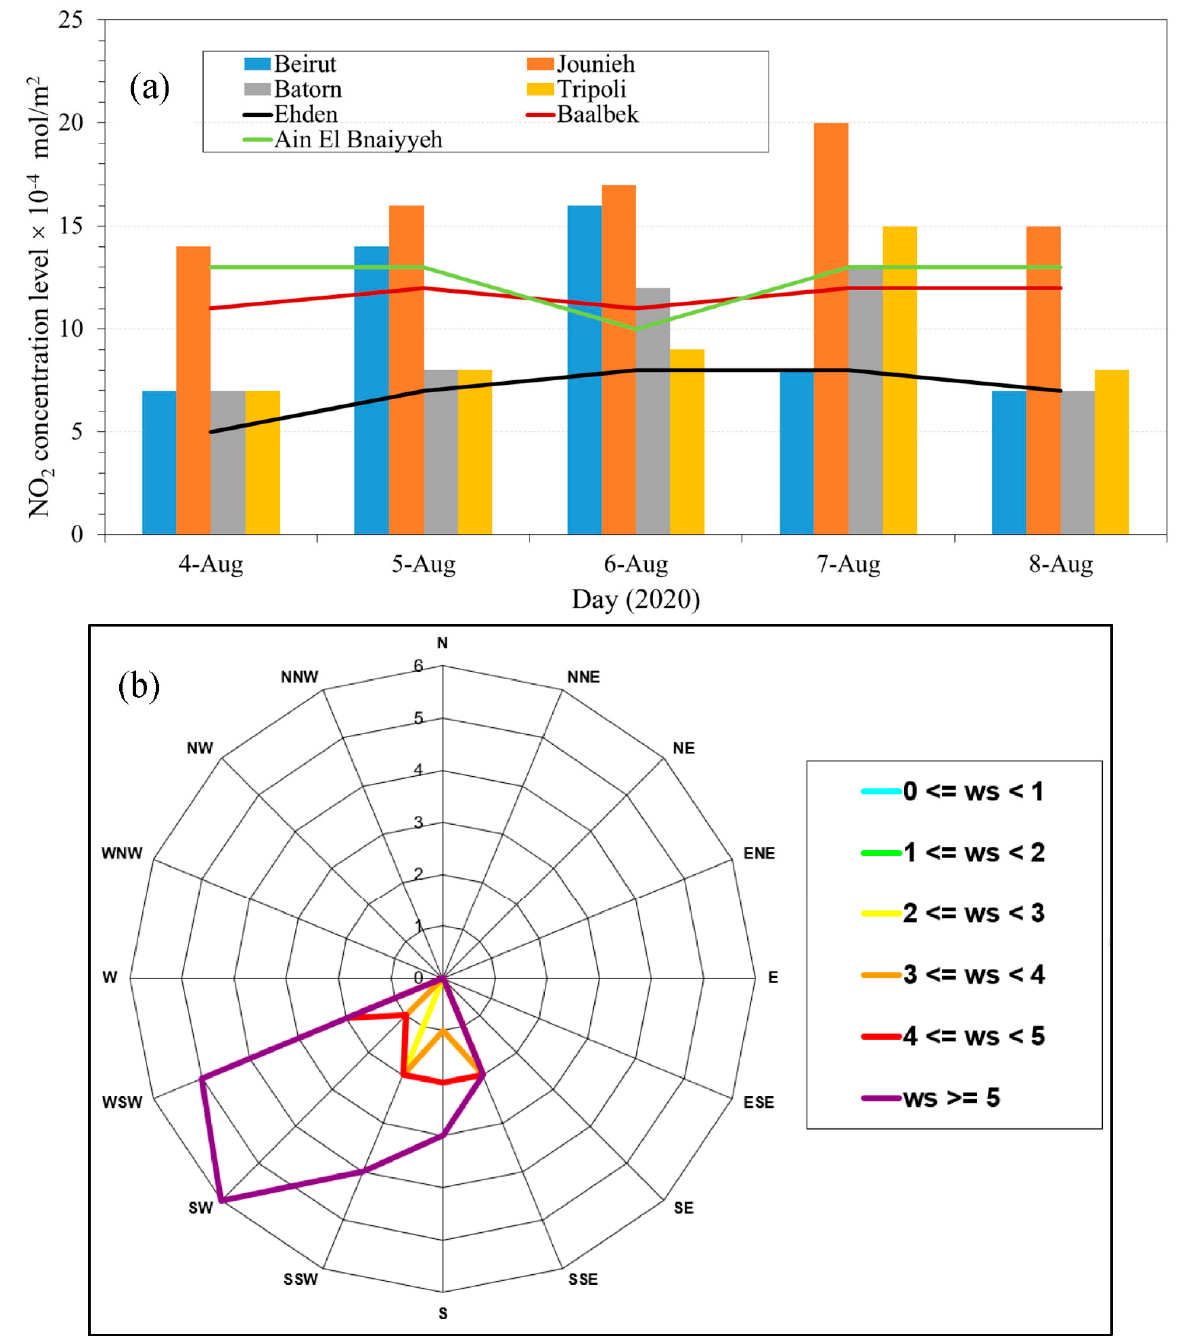
Figure 9. ( a ) NO 2 concentration levels × 10 − 4 mol/m 2 from 3 to8 August 2020 in the eight locations. Coastal locations (Beirut, Jounieh, Batron, and Tripoli) are represented by bars and inland locations (Ehden, Baalbek, and Ain El Bnaiyyeh) are represented by lines ( b ) Wind Rose of the wind speed and direction over Beirut from 4 to 8 August 2020.